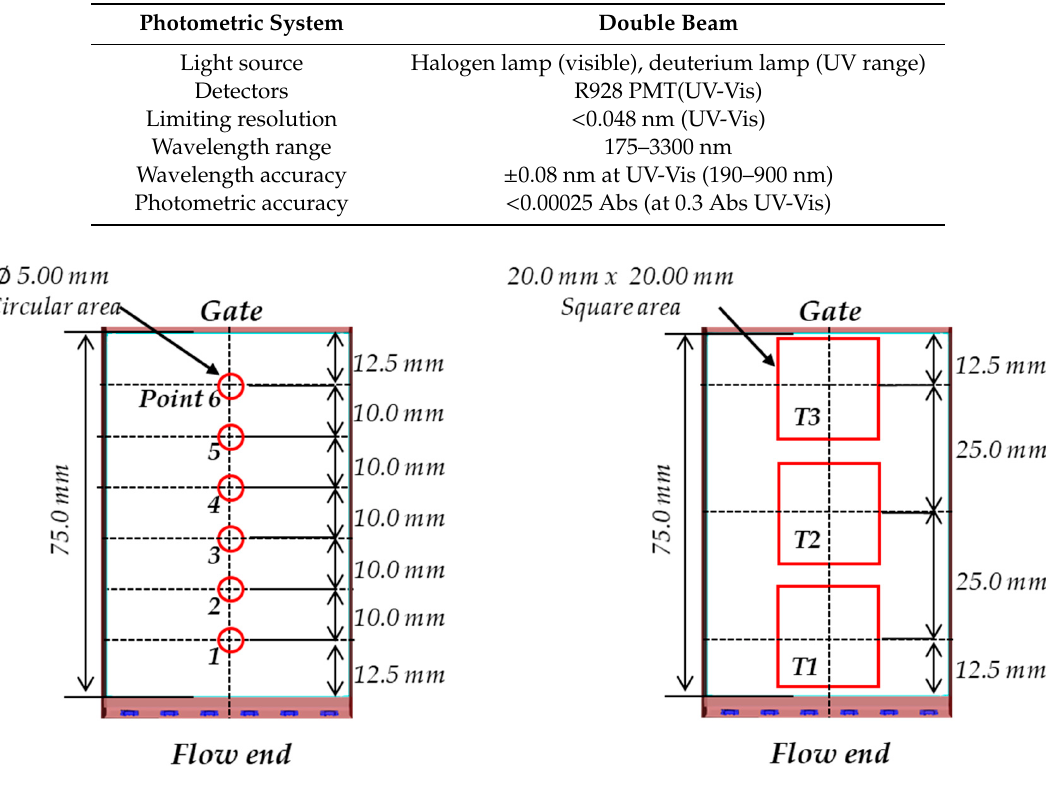
Table 5. Performance specifications of Cary 5000 UV-Vis-NIR spectrometer.